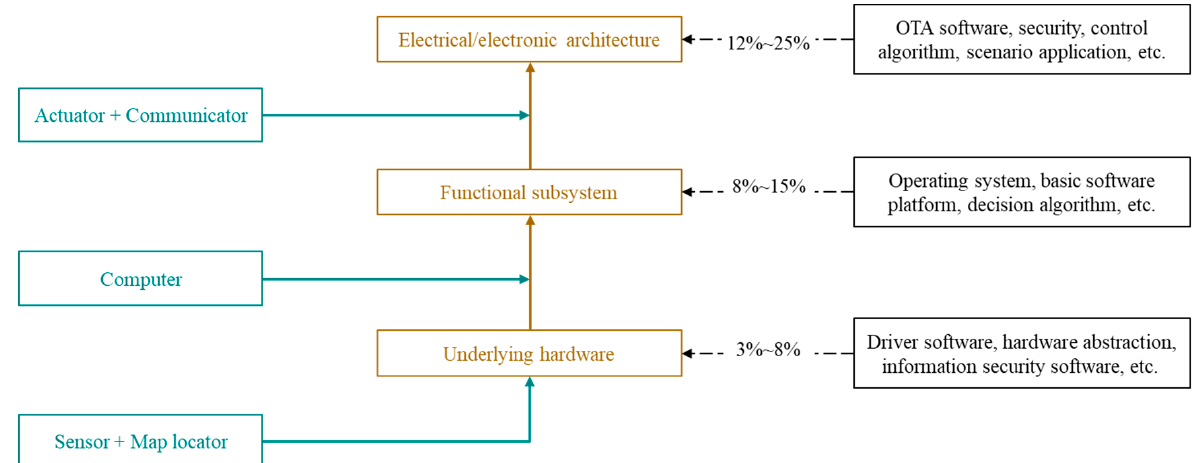
Figure 3. Evaluation model of software cost proportion.